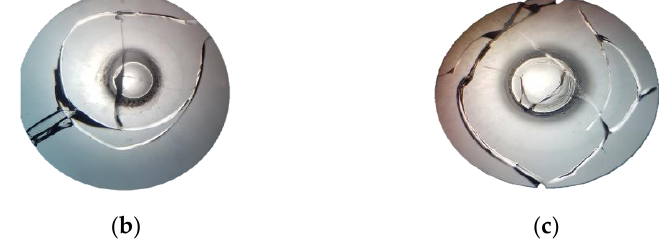
Figure 18. Holes drilled in air: ( a ) T E = 1 s, P = 5 W, N P = 2 pulse, ( b ) T E = 2 s, P = 10 W, N P = 1 pulses and ( c ) T E = 2 s, P = 15 W, N P = 1 pulse.